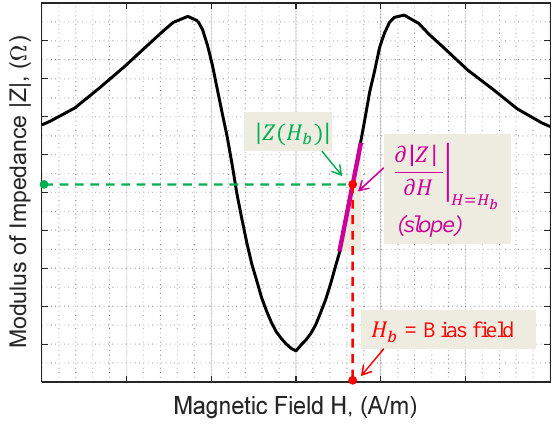
56 Figure 1. A typical GMI curve, | Z(H) | Figure 1. A typical Giant Magneto-Impedance (GMI) curve, | Z ( H ) |